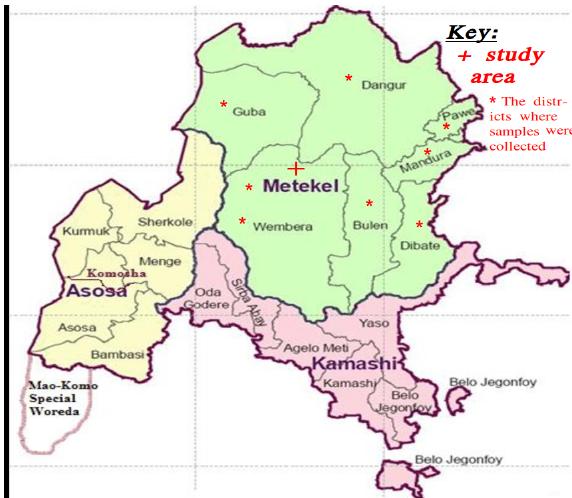
Fig. 1. Map of the study sites in Benishangul Gumuz province, Ethiopia. The astriks shown the areas (districts) where the samples were collected